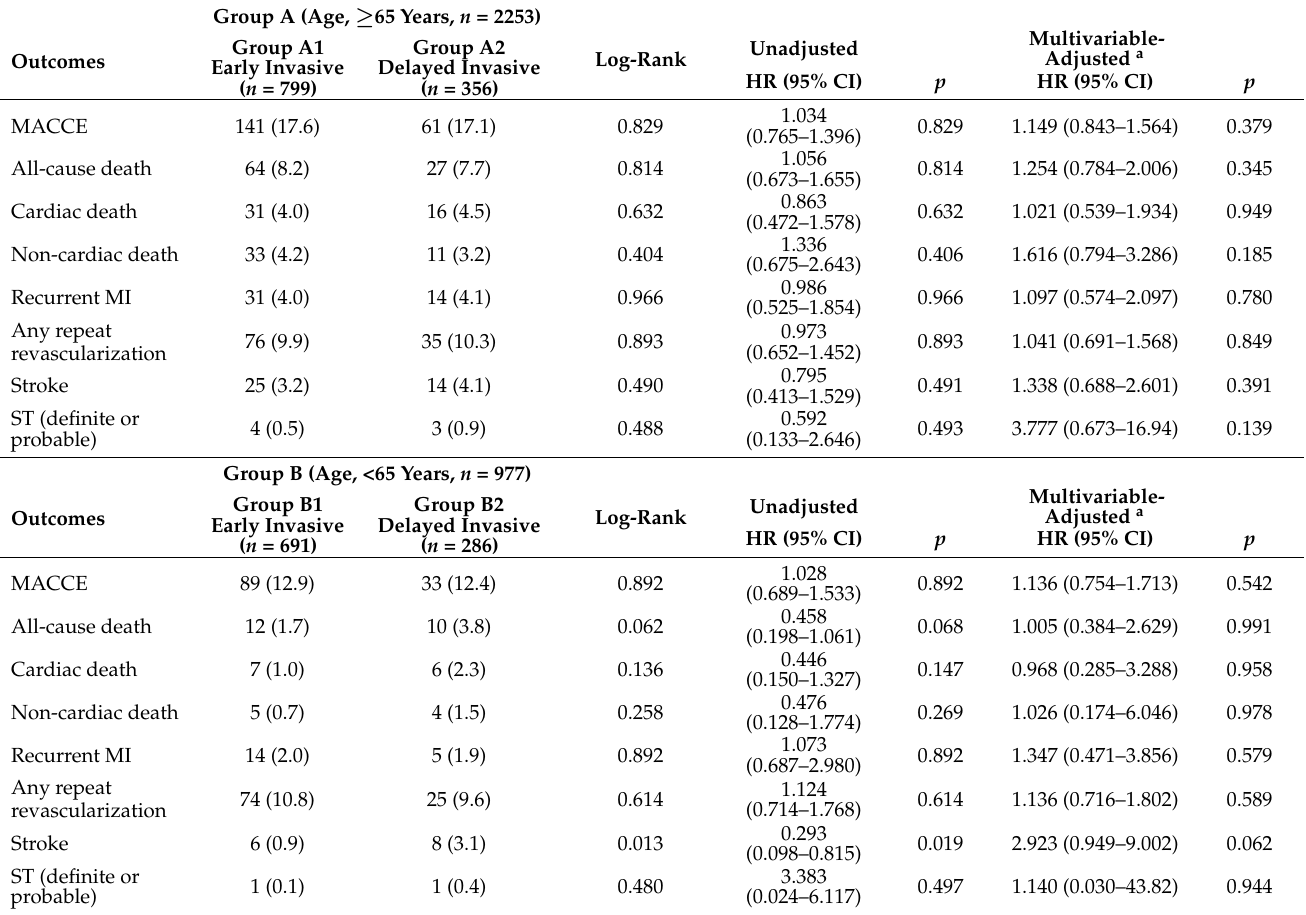
Table 3. Comparison of clinical outcomes in patient with complex coronary